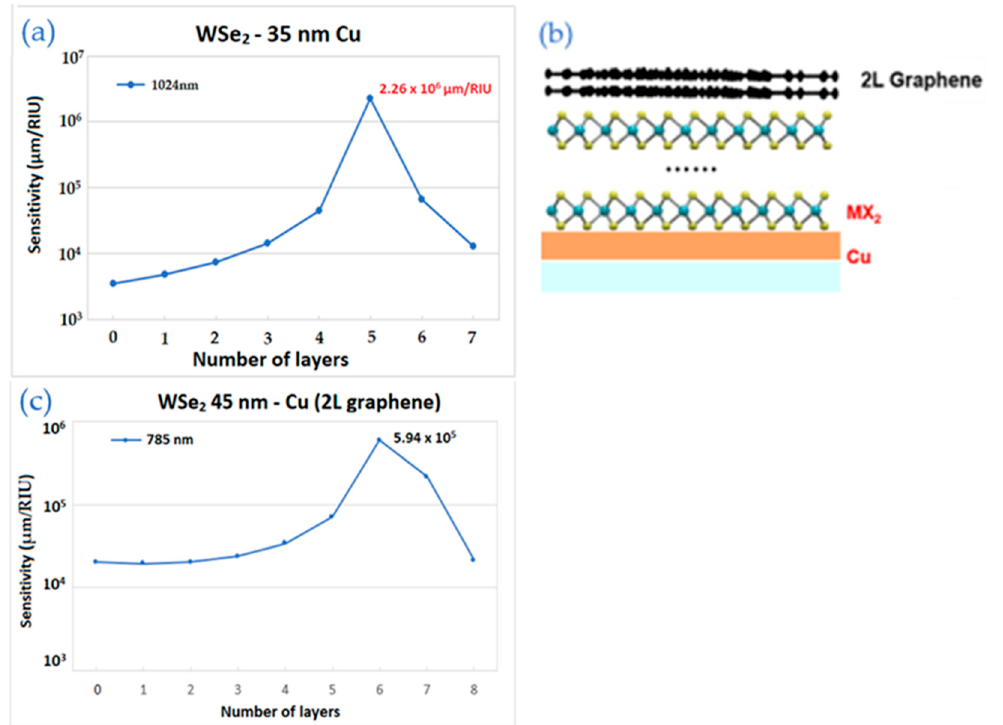
Figure 7. The sensitivity values of the enhanced model with 2 layers of graphene by TMDC layers and thickness copper: ( a ) The wavelength is 1024 nm for WSe 2 layers with 35 nm of copper; ( b ) the schematic structure; ( c ) The wavelength is 1024 nm for WSe 2 layers with 45 nm of copper.